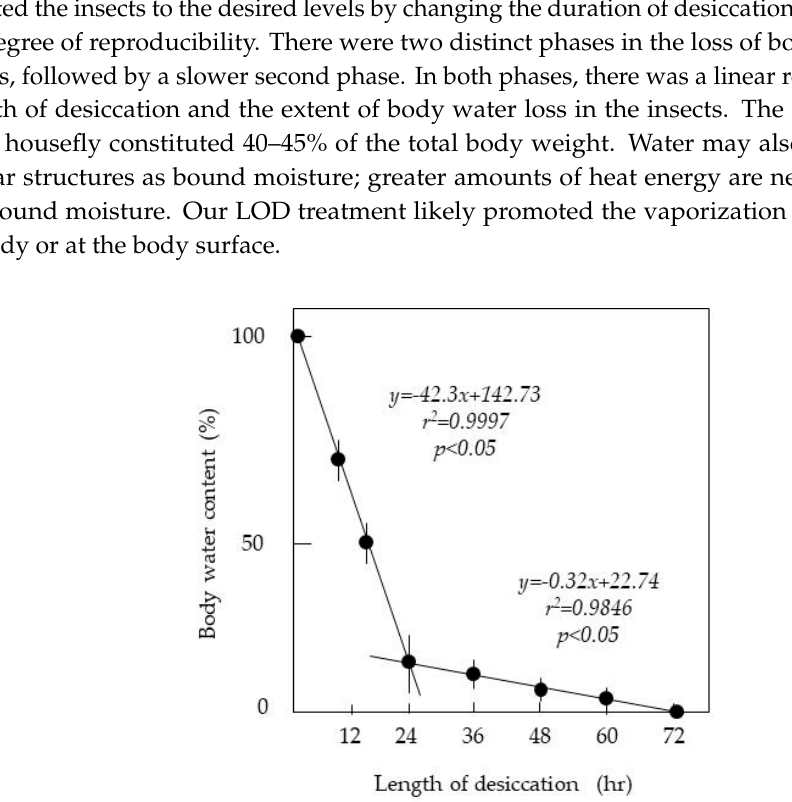
Figure 2. Relationship between the duration of desiccation and loss of body water in adult houseflies with the LOD method. Twenty insects were used for each desiccation duration.